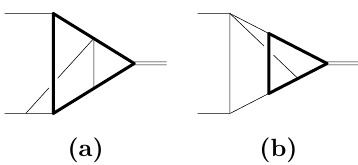
√ x . The notation is the same as for figure